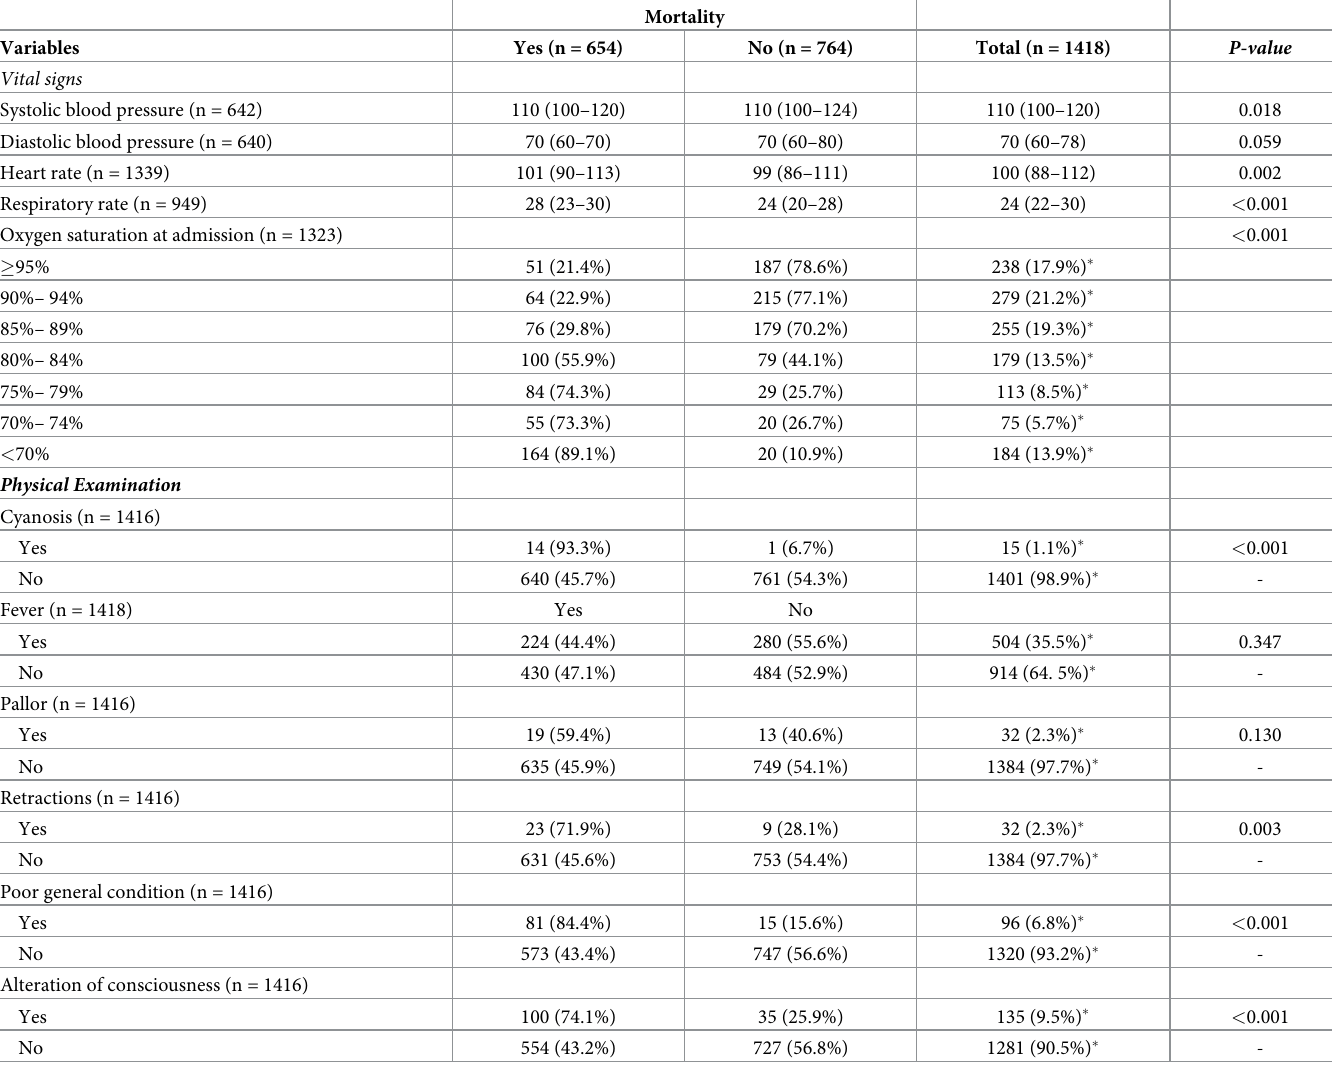
Table 3. Clinical characteristics and mortality risk in patients with COVID-19 admitted to the Hospital Nacional Hipo´lito Unanue from April to August 2020. Lima, Peru.